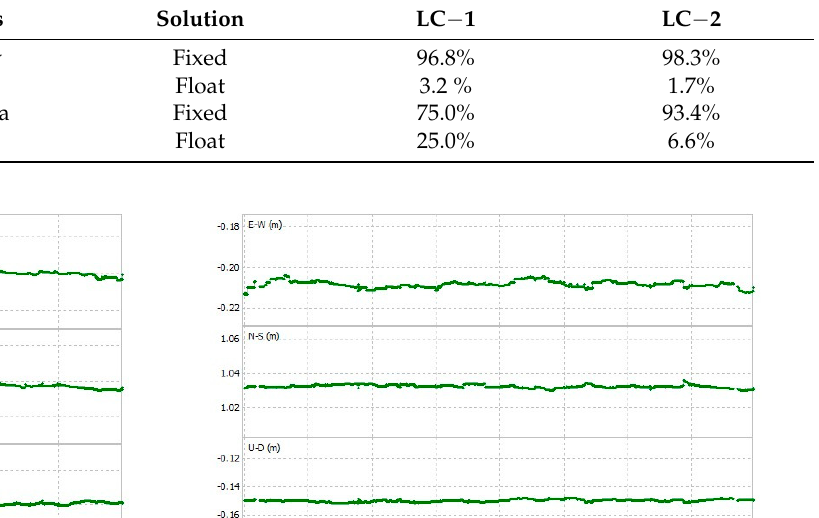
Table 3. Ambiguity resolution ratio for LC − 1 and LC − 2.